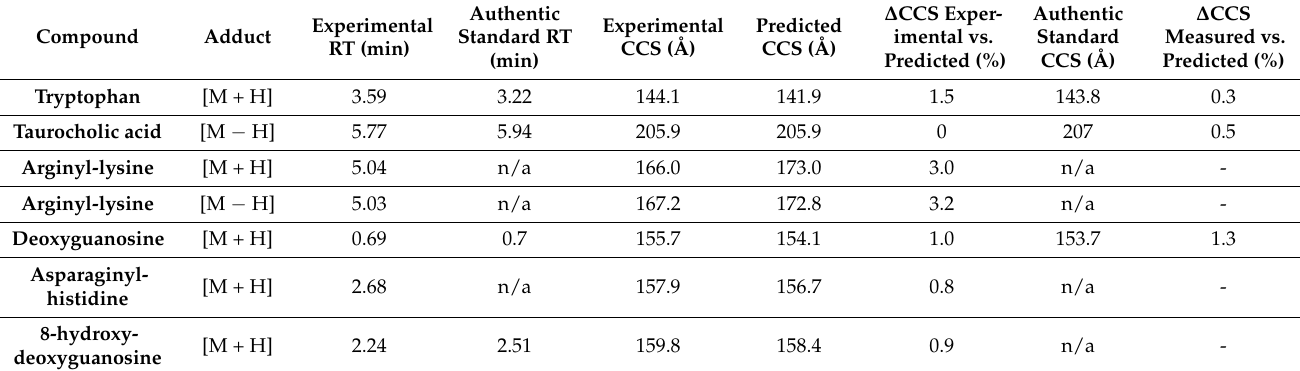
Table 1. Analytical data for metabolites identified in positive ESI MS as significantly contributing to the PCA. Compound